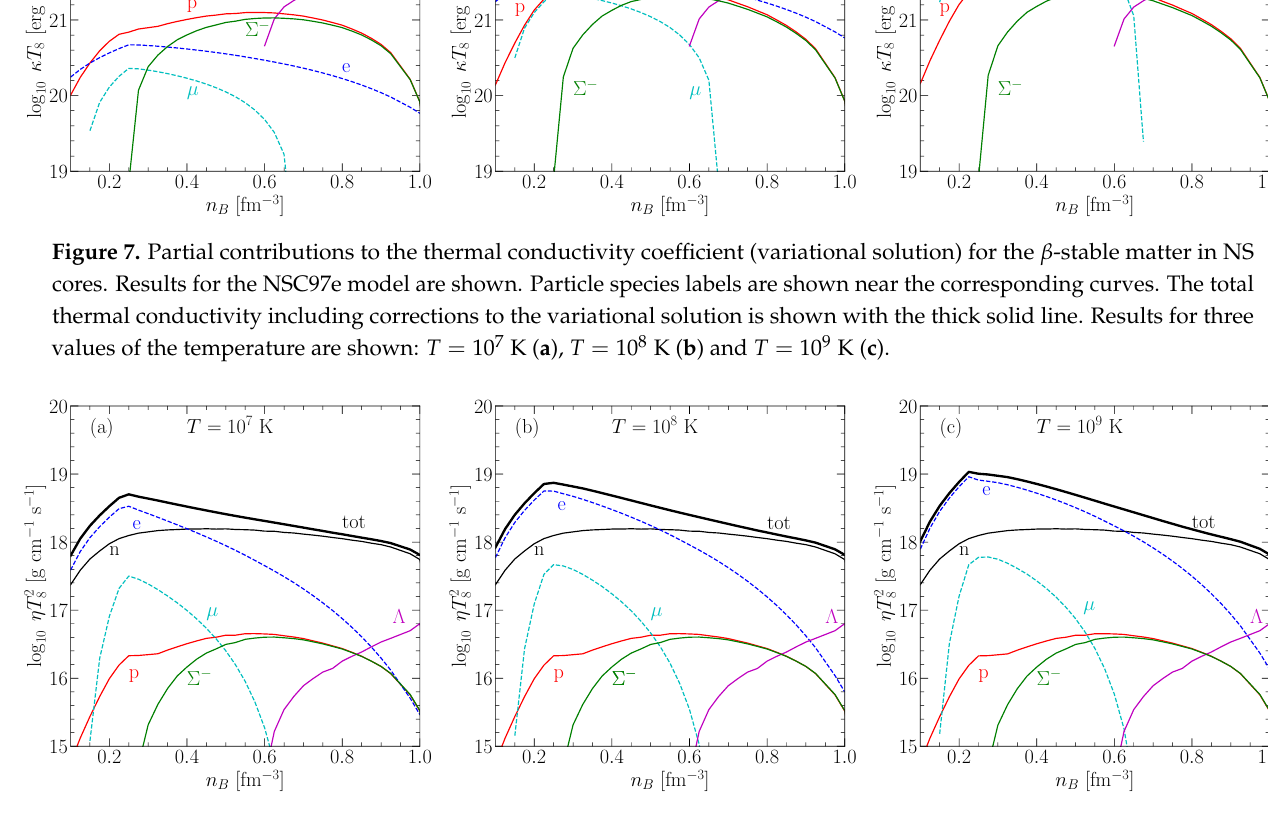
Figure 8. Partial contributions to the shear viscosity coefficient (variational solution) for the beta-stable mater in NS cores. Results for the NSC97e model are shown. Particle species labels are shown near the corresponding curves. The total shear viscosity including corrections to the variational solution is shown with the thick solid line. Results for three values of the temperature are shown: T = 10 7 K ( a ), T = 10 8 K ( b ) and T = 10 9 K ( c